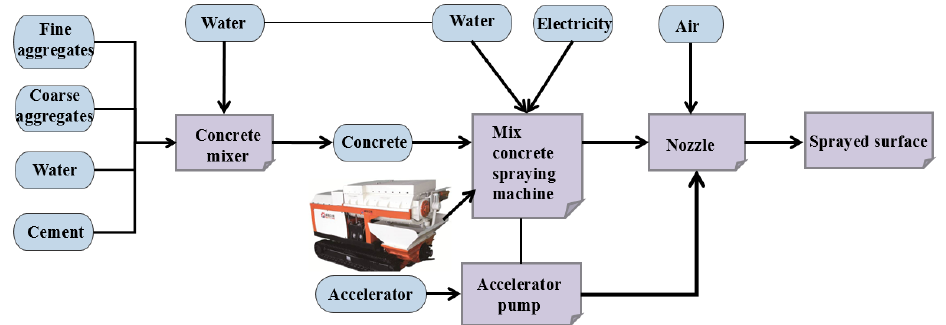
Figure 14. Process flow of concrete wet spraying.